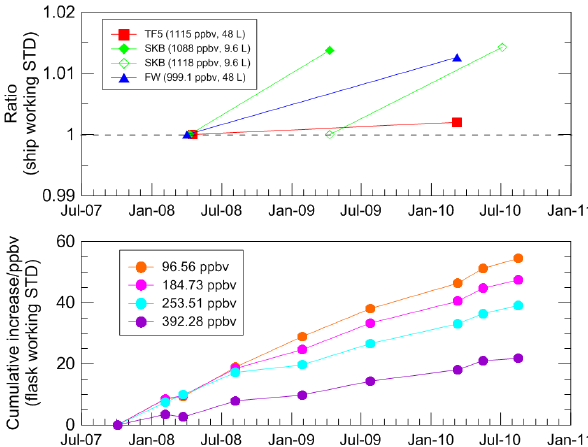
1 Figure 5. Calibration history of CO gas standards used for continuous onboard CO 2 Fig. 5. Calibration history of CO gas standards used for continuous measurement (upper) and flask analysis (lower). Note that onboard CO standard gases were 3 onboard CO measurement (upper panel) and flask analysis (lower calibrated before and after use, whereas the standards for flask analysis were calibrated 4 panel). Note that onboard CO standard gases were calibrated be- fore and after use, whereas the standards for flask analysis were periodically. 5 calibrated